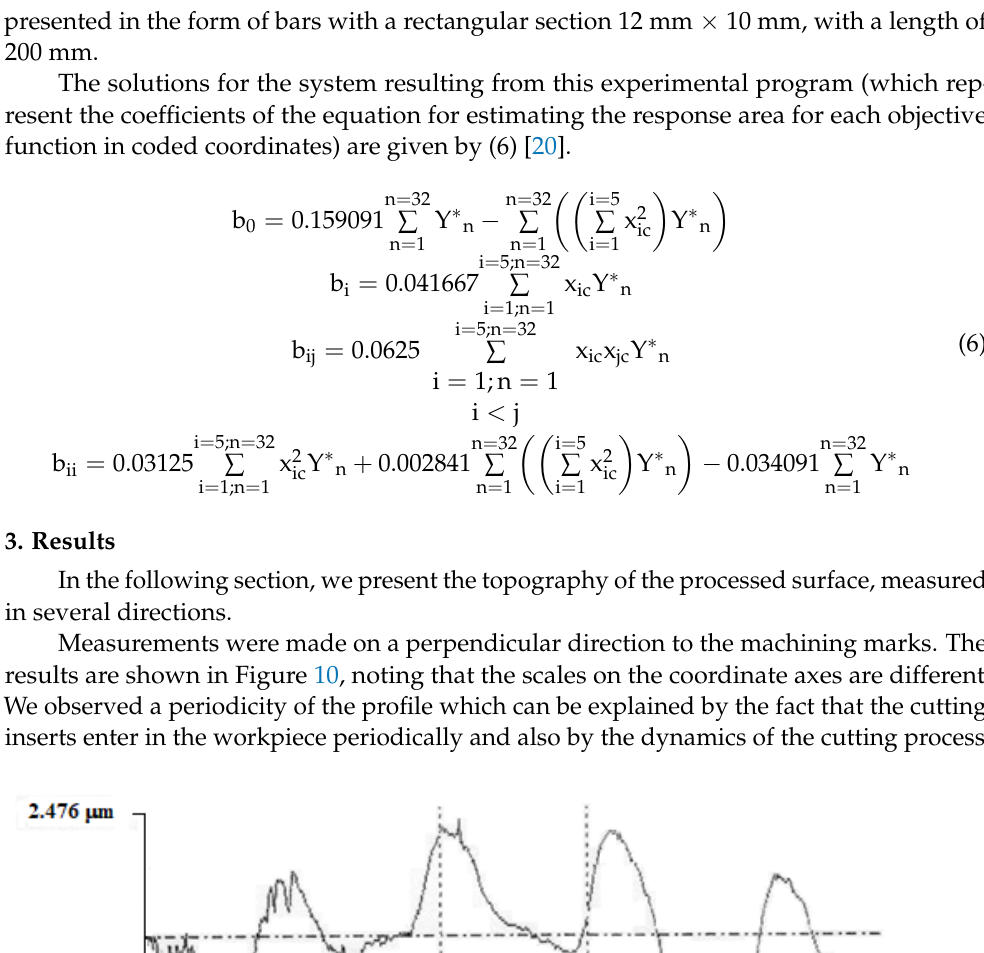
Figure 11. View manufactured surface with a chip root (×100); (a portion of the ×500 scale view is shown at the top).